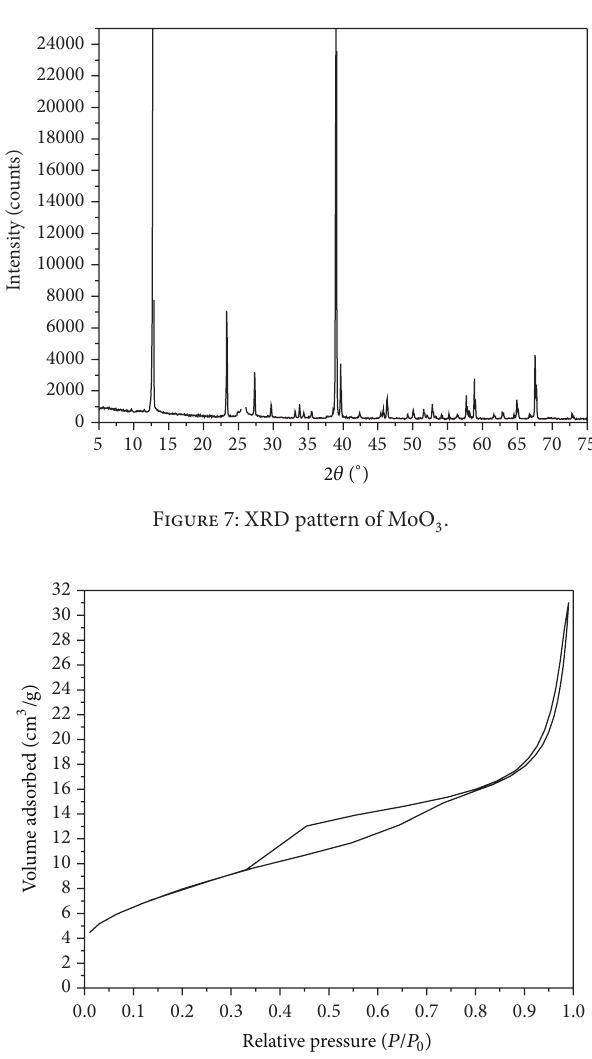
Figure 8: Nitrogen adsorption-desorption isotherm of ZrO 2 .